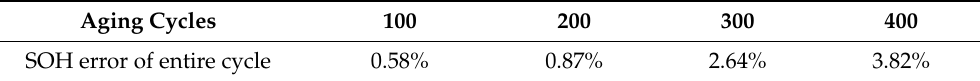
Table 6. SOH estimation error of entire cycle in the aging